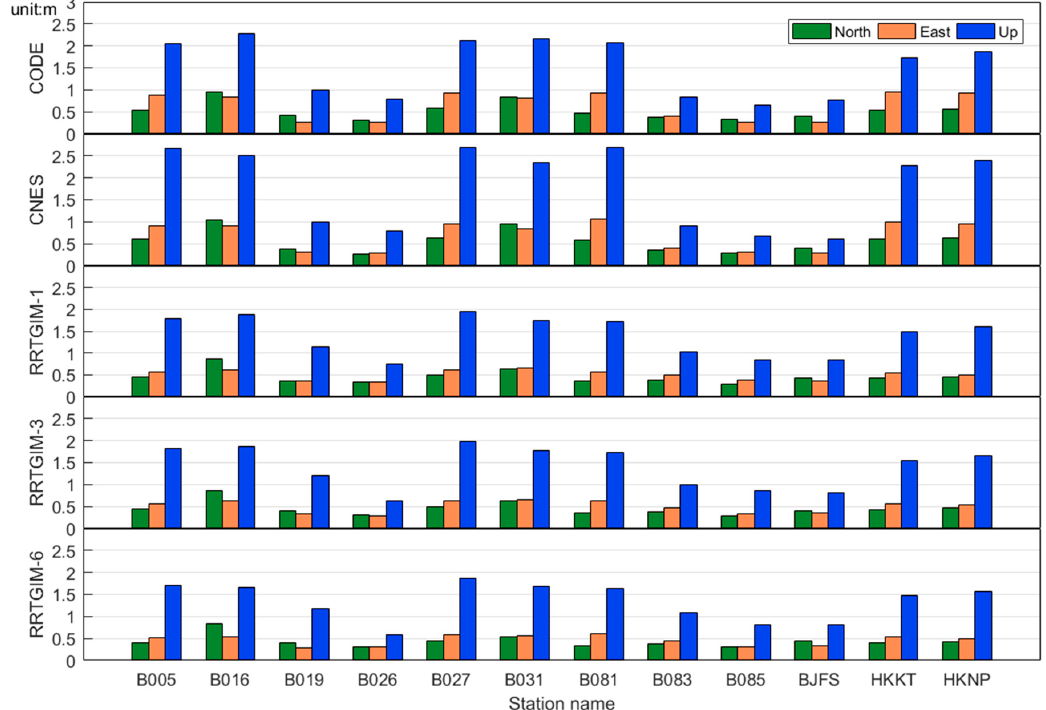
Figure 16. Positioning accuracy of SF-PPP using five products on DOY 78, 2020.